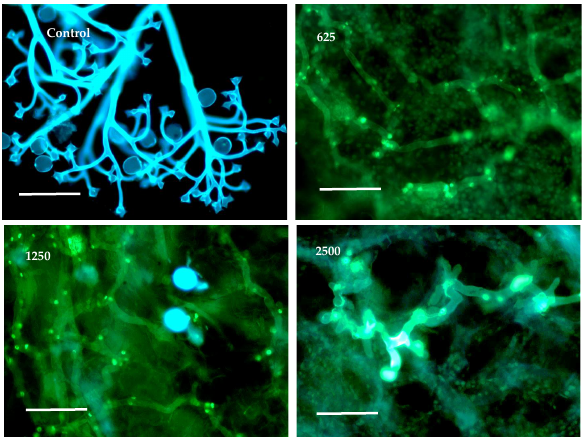
Figure 5. Fluorescence micrographs showing the effect of pure TTO (625, 1250, and 2500 µg/mL a.i.) on sporulation of B. lactucae in lettuce leaves. Sporophores and spores fluoresce blue. Bar = 50 µm. Photos were taken at 5 d after inoculation.